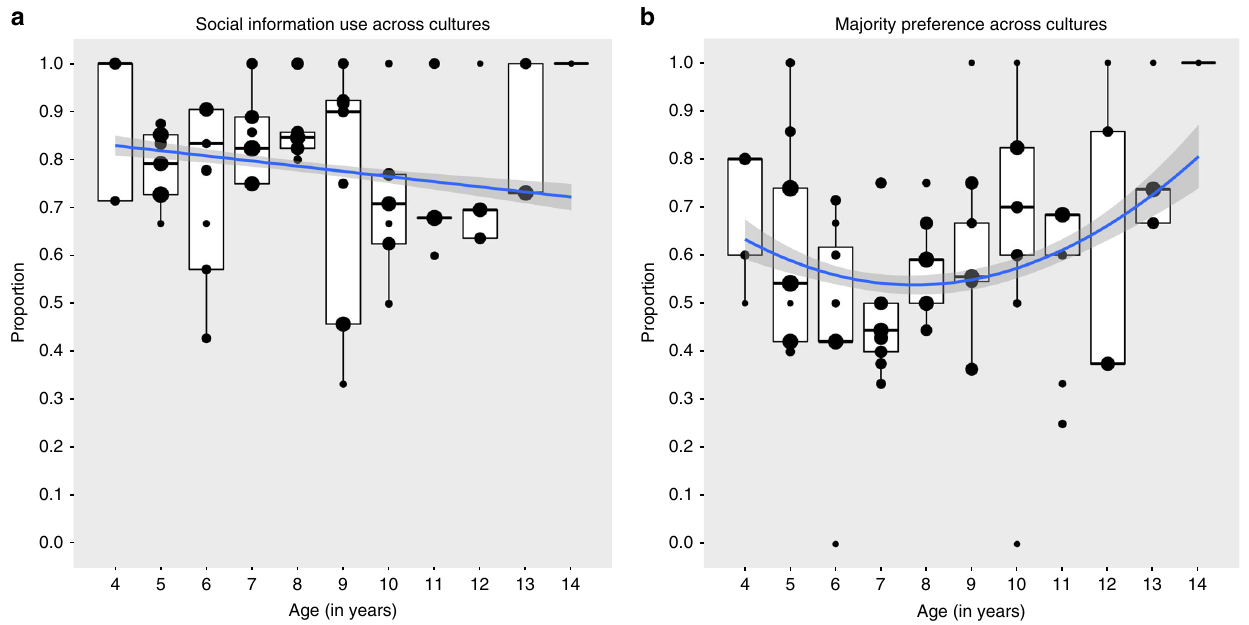
Fig. 1 The ontogeny of social learning in human children. Depicted are a children ’ s reliance on social information (vs. innovation), and b majority (vs. minority) preference, across cultures. Blue lines represent ontogenetic trajectories across cultures; shaded area around the blue lines represent 95% con fi dence intervals. Medians are represented by the bold, horizontal lines within the boxes. The boxes represent the interquartile range (IQR), the vertical lines attached to the boxes represent Q1 – 1.5 IQR (lower) and Q3 + 1.5 IQR (upper). Dot size in a is proportional to the number of observations in ratio 1:5, with minimum and maximum number of observations per dot being 1 and 33, respectively. Dot size in b is proportional to the number of observations in ratio 1:5, with minimum and maximum number of observations per dot being 1 and 24,